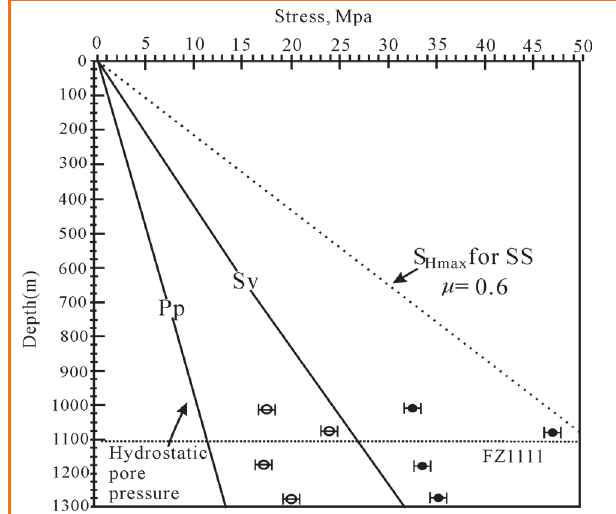
Figure 3. Plot of overburden stress (Sv) from integration of density logs, pore pressure, and S Hmax (filled symbol) and S hmin values (open symbol) determined from leak-off tests at different depths. The calculated upper bound S Hmax (dashed line) for a strike-slip faulting stress regime assuming coefficient of friction µ =0.6 and location of FZA1111 are also shown.